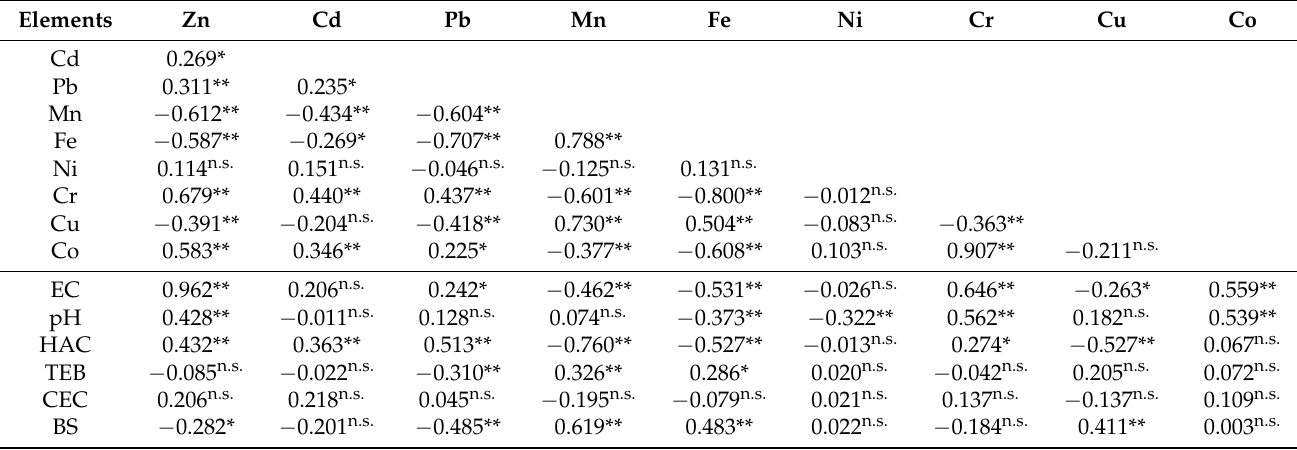
Table 4. Correlations ( r ) between the content of available trace elements and selected properties of the soils.